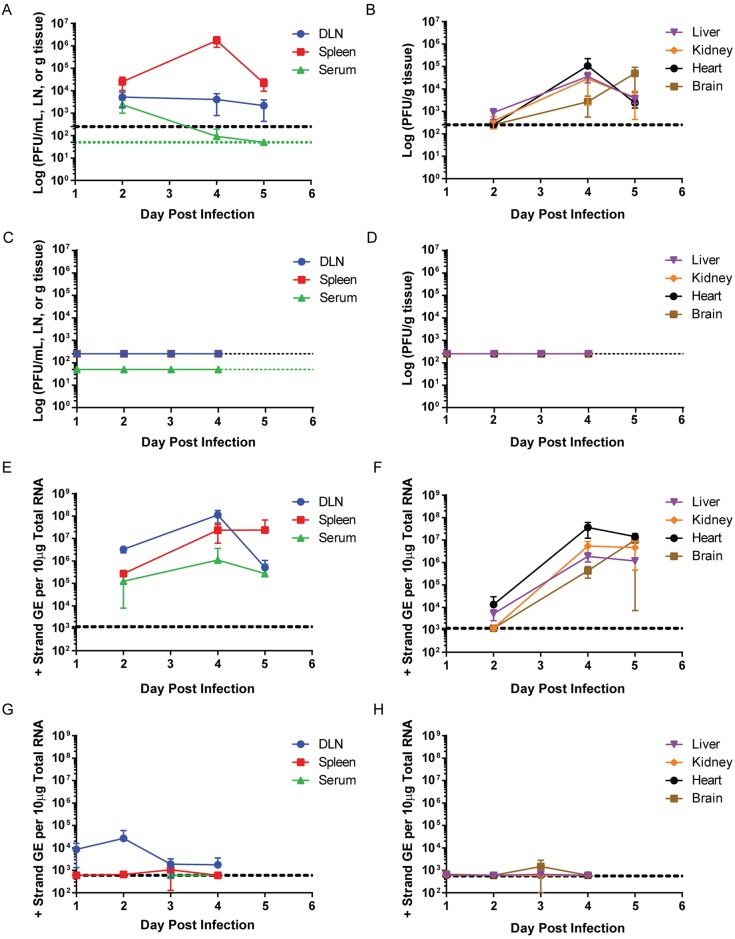
Immunization with 17D-204 restricts replication of wtYFV following challenge.(A-B, E-F) Naive or (C-D, G-H) 17D-204-vaccinated 8 week old mice were infected s.c. with Ang71. On the indicated days p.i., tissues were harvested and (A-D) PFU or (E-H) genomic equivalents [GE] were determined by (A-D) standard plaque assay or (E-H) RT-qPCR (n = 6 for all groups). The black hashed line indicates the (A-D) limit of detection [LD] or (E-H) limit of quantification [LOQ]. (A, C) The green hashed line indicates the LD for serum samples.